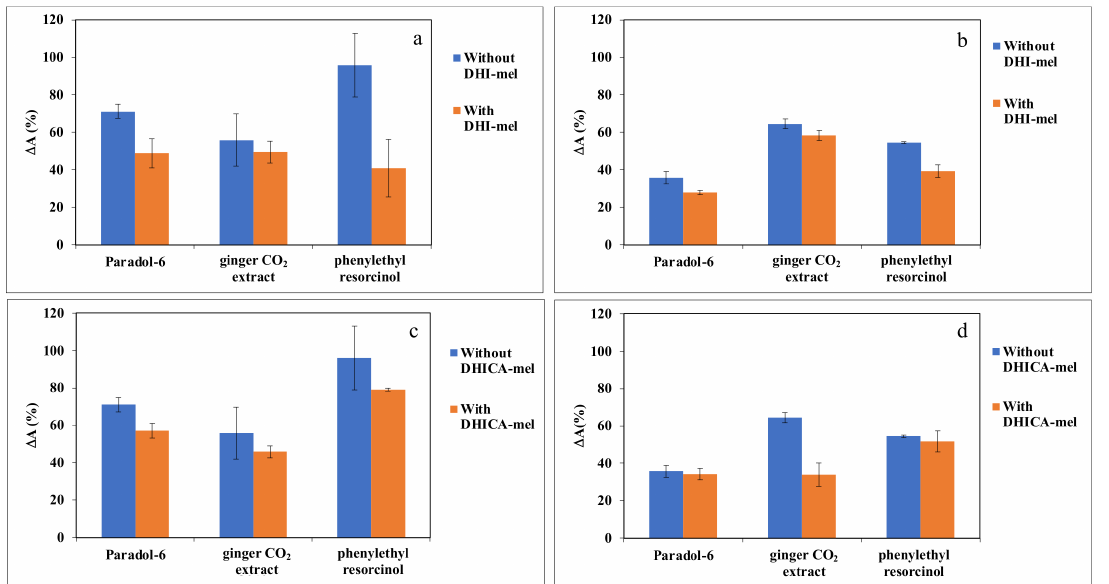
Figure 7. Changes of the absorbance at 234 nm of 2.5 mM linoleic acid oxidation mixture containing: 20 µ M of RF ( a , c ); or 20 µ M of RB ( b , d ), 20 µ M of selected CI (paradol-6, ginger CO 2 extract and phenylethyl resorcinol) and 0.05 mg/mL DHI-mel ( a , b ); or 0.0125 mg/mL DHICA-mel ( c , d ). Data are expressed as mean ± SD of three independent experiments, each performed in